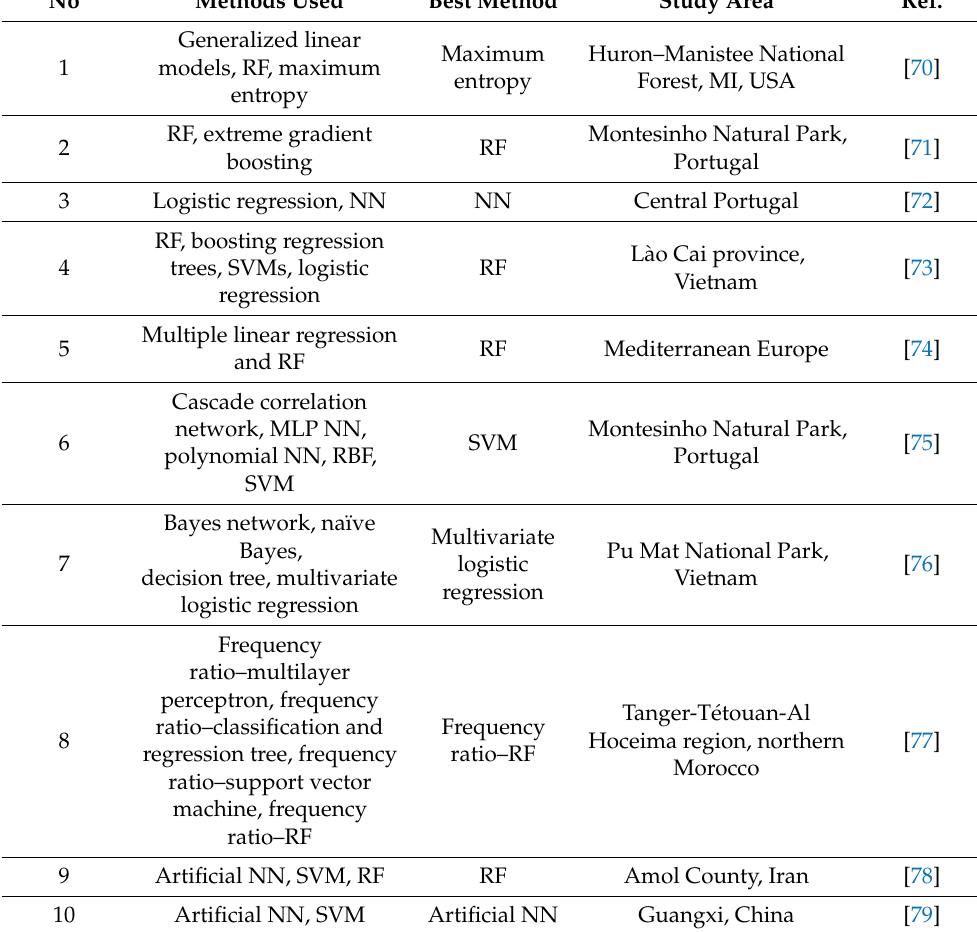
Table 2. Suitability of classifiers in FF modeling according to previous